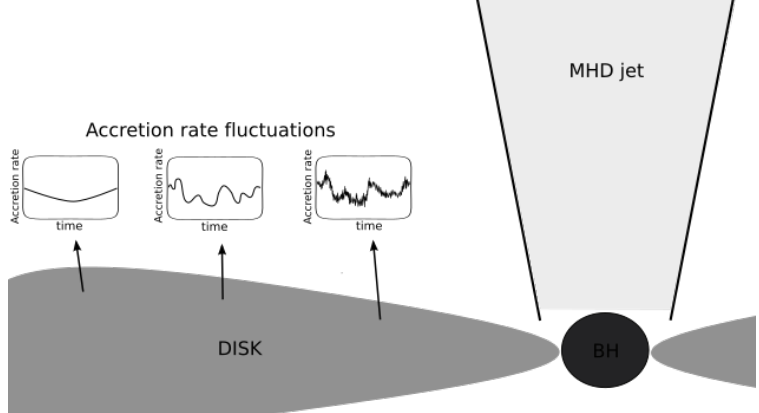
Figure 6. A possible accretion-disk origin for log-normality. Density fluctuations in the disk, arising on local viscous timescales, can propagate inwards and couple together so as to produce a multiplicative behavior in the accretion rate. If this is transmitted to the jet and picked up by the acceleration mechanism, the resultant VHE emission might share in the underlying log-normal